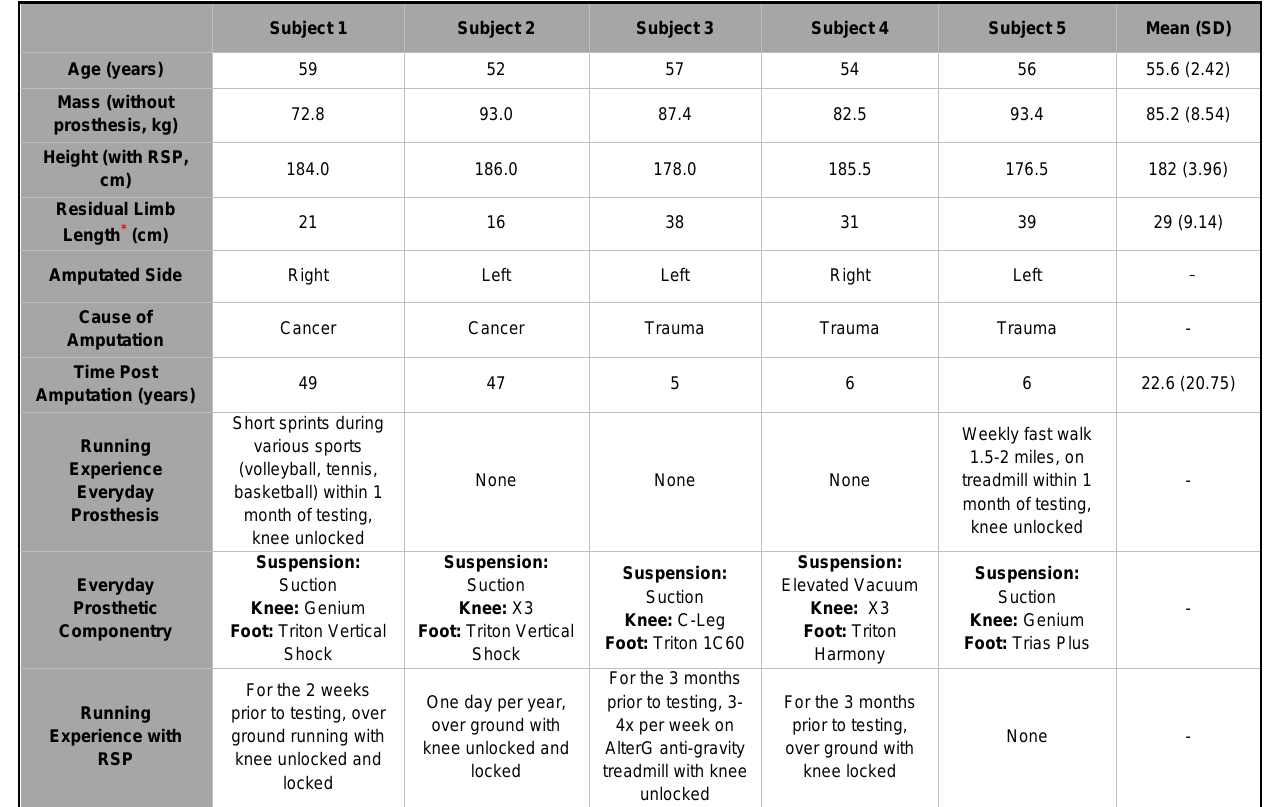
Table 1: Subject characteristics and running experience. * Distance from the greater trochanter to the most distal point on the femur (as determined by